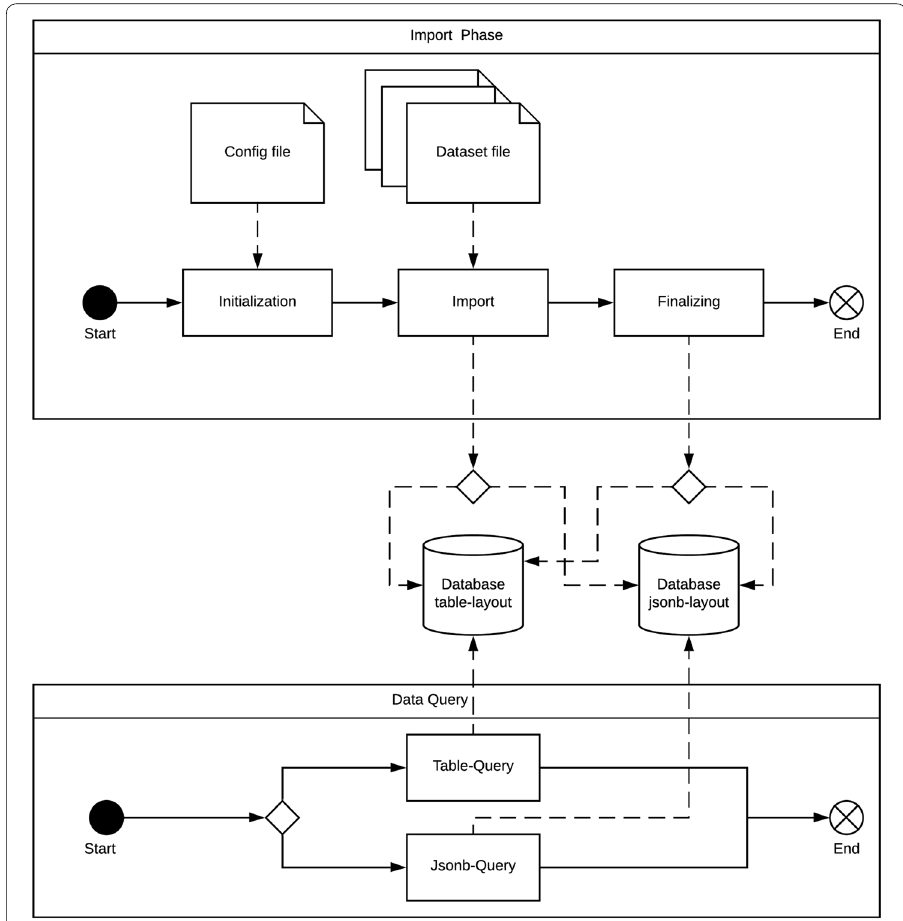
Fig. 4 An overview of the experimental setup. The import phase (top section) consists of three phases, and results in a database populated with the import dataset, using either the table-layout or the jsonb-layout, depending on the chosen storage strategy indicated in the config-file. The query phase is a separate